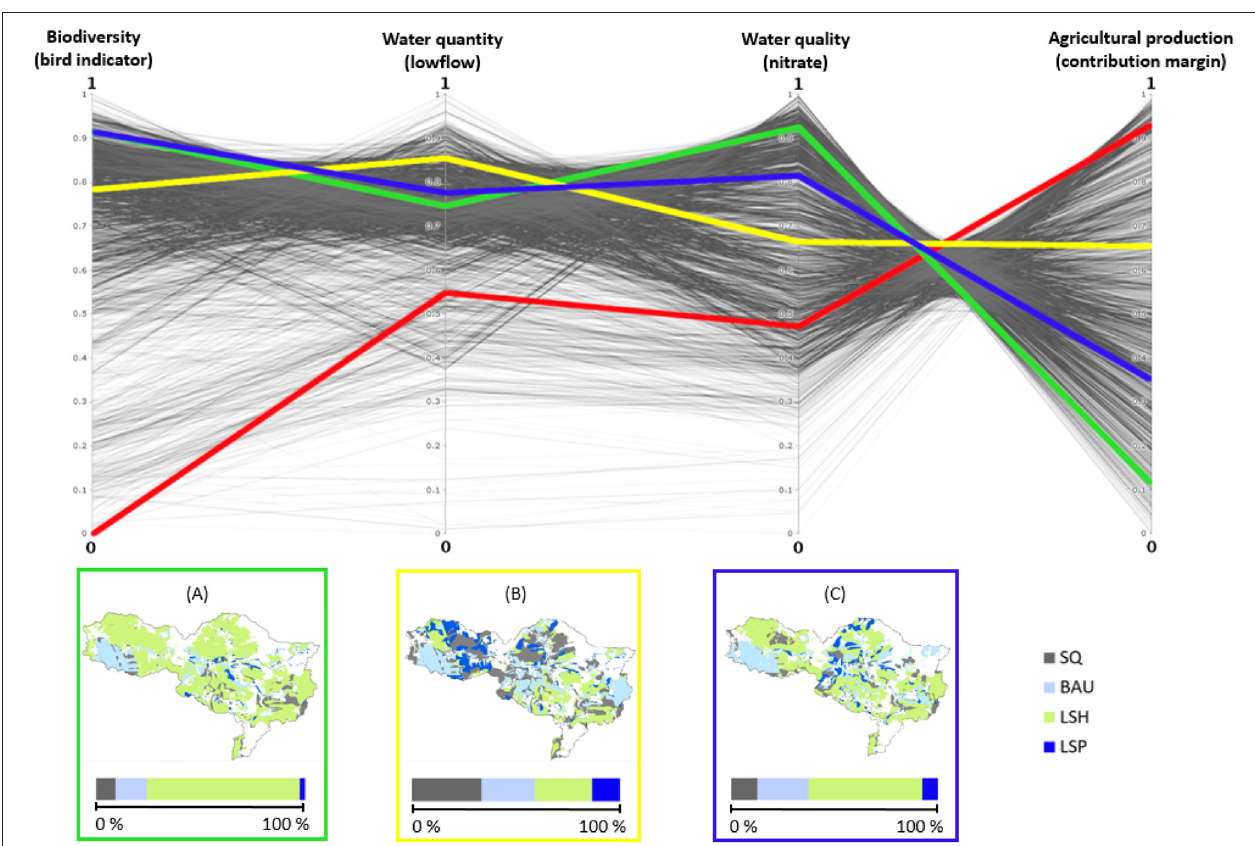
FIGURE 5 | Parallel coordinates plot of the Pareto-optimal solutions with the three AHP best solutions (A) —green line, (B) —yellow line, and (C) —blue line. The red line marks the status quo. The respective spatial distribution and the percental share of the land management scenarios are shown in the boxes below the plot.